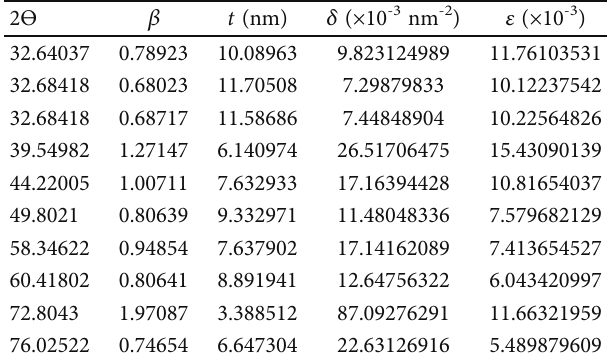
. 2 Table 2: Microstrain ( ε ), average crystallite size ( t ), and dislocation density ( δ ) of synthesized MoS 2